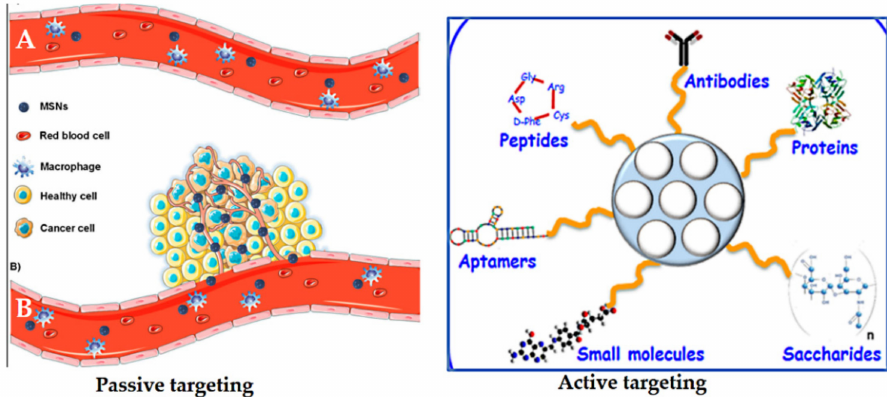
Figure 18. Schematic representation of the enhanced permeability and retention (EPR) effect (lift side). ( A ) Normal blood vessels (no fenestrations), showing that MSNs remain in the bloodstream. ( B ) Tumor tissues (defective blood vessels present) showing that MSNs leak out through the en- dothelial gap–gap and eventually accumulate in the tumor. On the right is a schematic depiction of active targeting with a variety of possibilities depending on the MSNs. Reproduced from [32,259], MDPI,